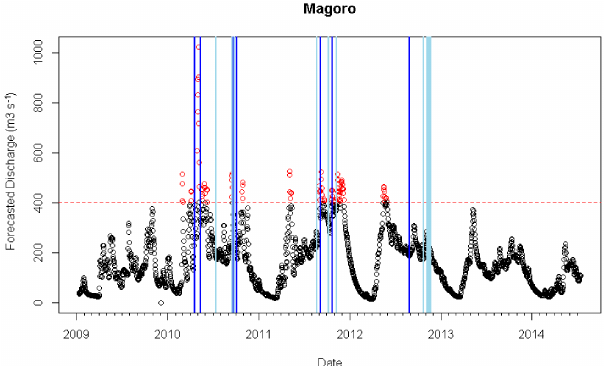
Figure 2. Forecasted discharge (circles) at Magoro sub-county, Uganda, represented by a GloFAS forecasts ensemble median at lead time 0. Dates of disasters in the regions along the Apapai River are indicated by dark blue vertical lines, as per the databases of the Uganda Red Cross Society and Desinventar. Newspaper reports of flooding in the district of Katakwi are indicated by light blue vertical lines. Small tick marks on the x axis correspond to months within a year. The horizontal dashed red line indicates the 95th percentile of estimated discharge; dates with discharge above this threshold are coloured in